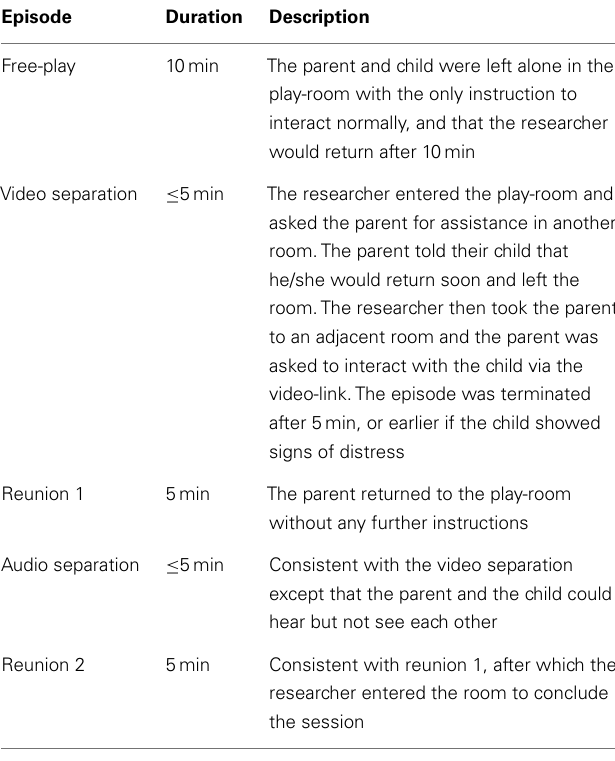
Table 1 | Description of the free-play, separation, and reunion